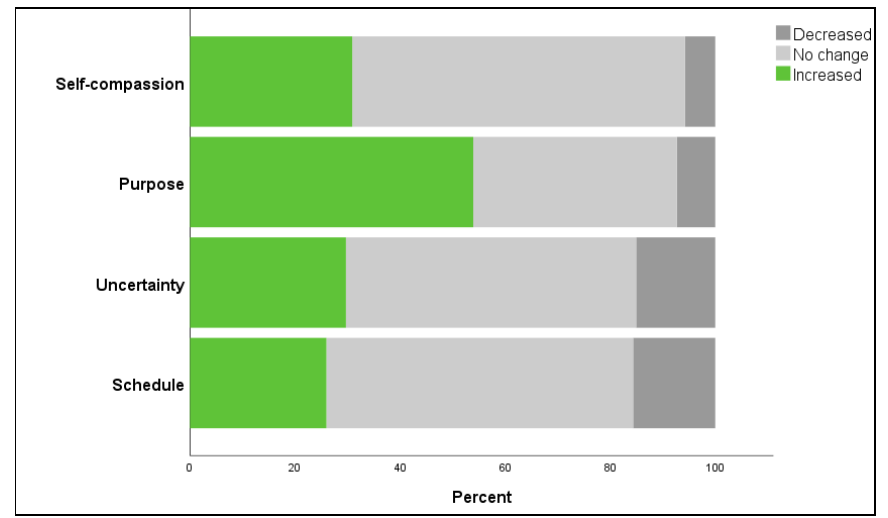
Figure 2. Reported impact of companion animals on COVID-19 related positive feelings. Prior to running binary regression on the negative and positive emotions/behaviors related to COVID-19, Pearson correlations were calculated for each of the nine emotions and potential predictive factors (see Table 4 for negative feelings and Table 5 for positive feelings). For each emotion, all correlated factors were entered into a binary regression model to determine the best predictors for each independent variable.